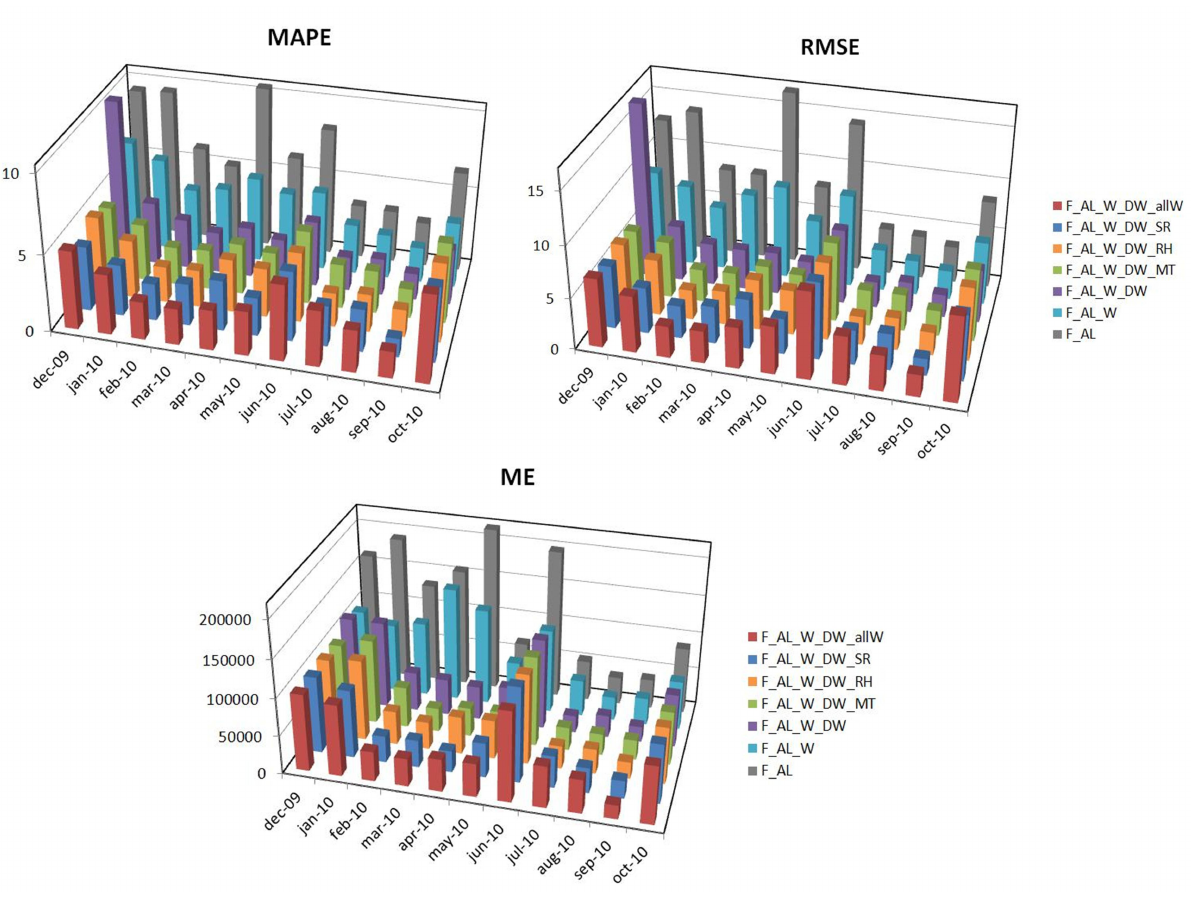
Figure 7. Evolution of MAPE (%), RMSE (dimensionless) and ME (W) during all days of the operation stage for each of the